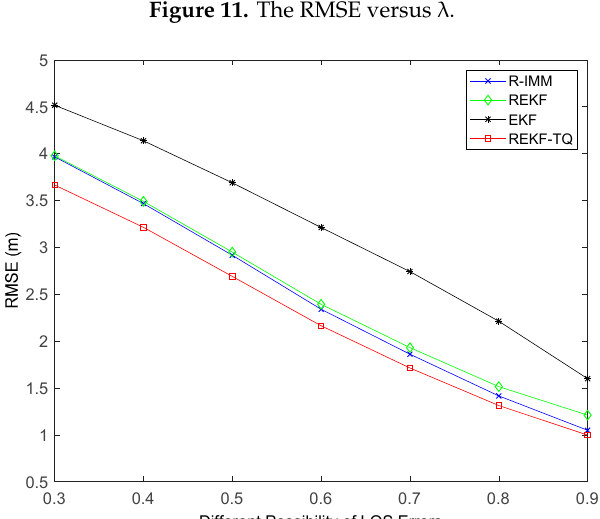
Figure 11. The RMSE versus λ .